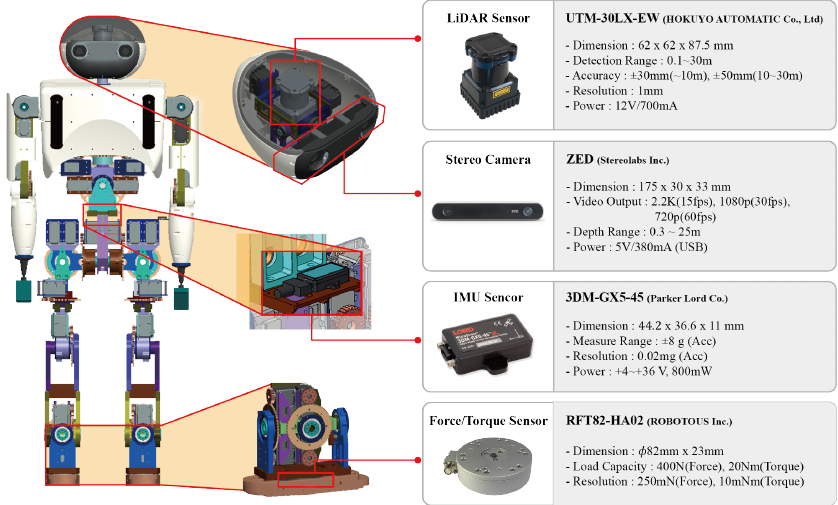
Figure 3. Design of DIANA’s sensors.